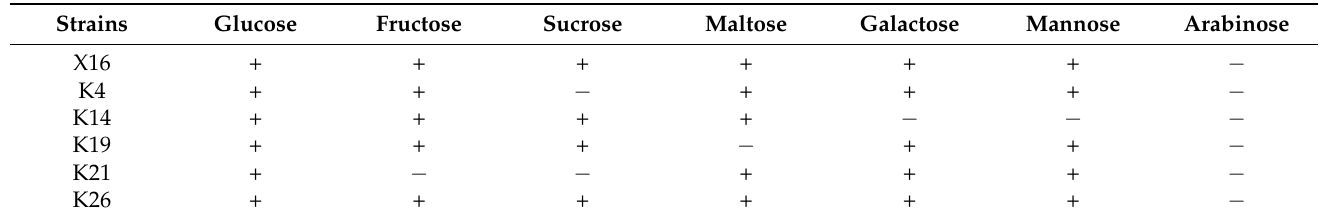
Table 2. Carbon source utilization characteristics of the selected yeasts isolated from Korla fragrant pear.